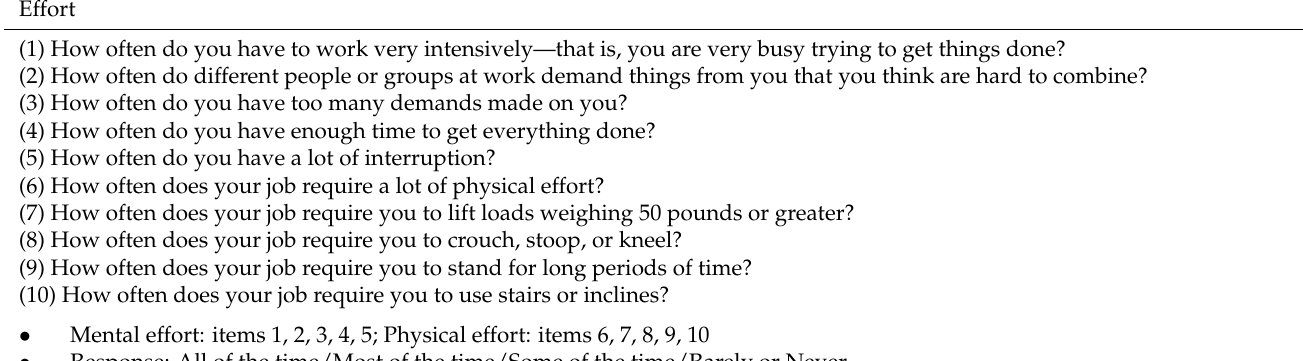
Table A1. Proxy measures of effort–reward imbalance (ERI) at work.